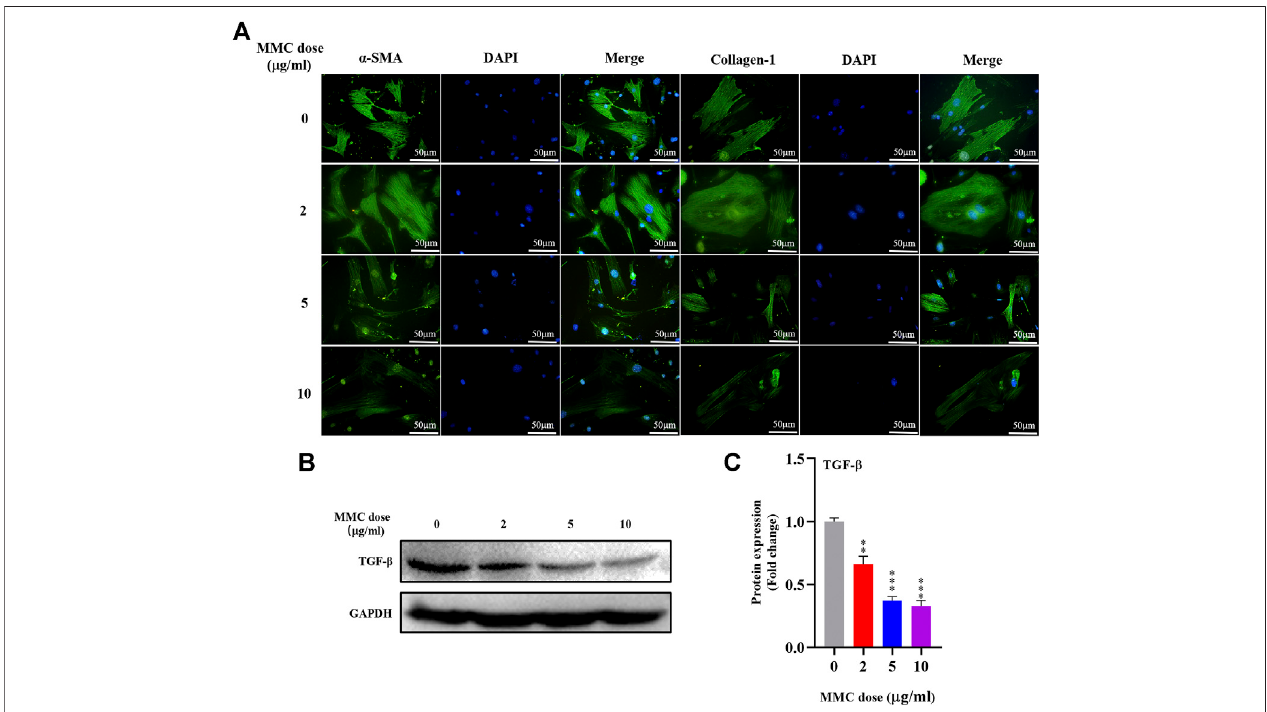
FIGURE 3 | MMC inhibited the expression of fi brotic marker proteins in HEFs. (A) Expression of α -SMA and collagen-1 were shown by immuno fl uorescence after treated with MMC at 2, 5, and 10 μ g/ml; (B) Western blotting was used to determine the expression levels of TGF- β treated with or without MMC for 24 h. (C) Relative protein expression level of TGF- β was shown compared with control group. * P < 0.05 ** P < 0.01*** P <